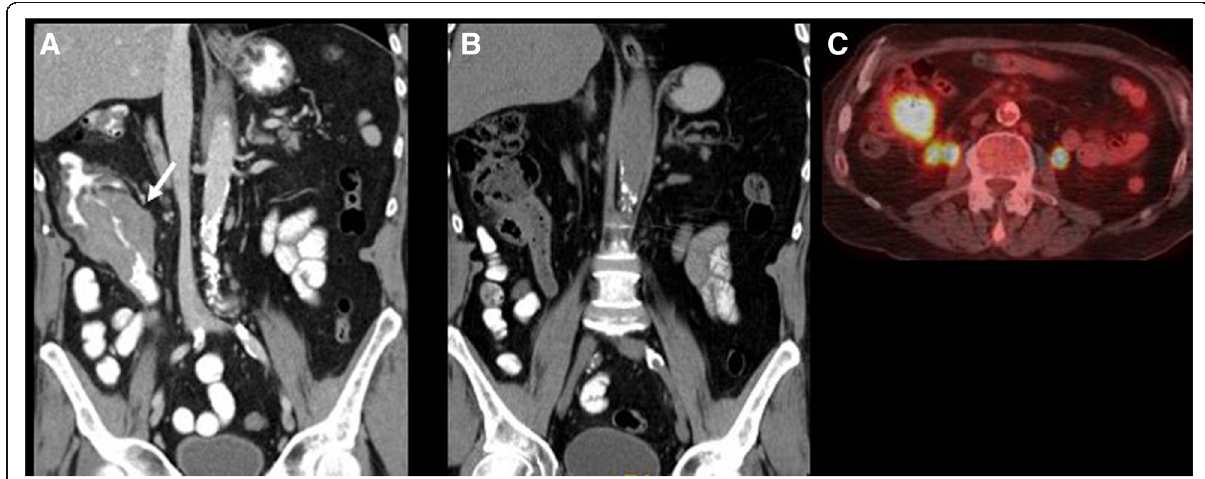
Fig. 3 A 65-year-old man with history of MALT lymphoma treated with rituximab with new onset fever and fatigue. a Coronal reconstructed CT image acquired during portal venous phase at time of diagnosis shows a large mass at the ascending colon (arrow). Biopsy of the mass demonstrated MALT lymphoma. b Coronal reconstructed CT image after 6 months of treatment shows resolution of the mass. c PET/CT axial fused image at new onset of symptoms shows intense focal FDG uptake in the region of the ileocecal valve with SUVmax 15.9. Biopsy of the mass showed histologic transformation to diffuse large B cell